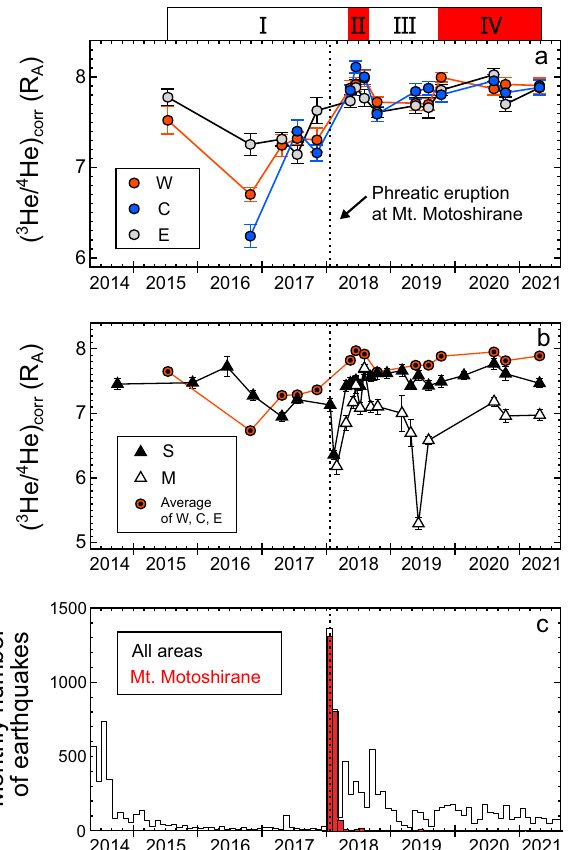
Figure 2. Temporal variations in air-corrected 3 He/ 4 He (( 3 He/ 4 He) corr ) ratios of fumarolic gases and monthly numbers of volcanic earthquakes at Kusatsu-Shirane volcano. ( a ) ( 3 He/ 4 He) corr ratios measured at the W, C, and E fumaroles in the Kitagawa geothermal area. The Roman numerals above the panel are periods defined by the average ( 3 He/ 4 He) corr ratios of the Kitagawa fumarolic gases. High average ( 3 He/ 4 He) corr ratios (> 7.8 R A ) were measured in periods II and IV. ( b ) ( 3 He/ 4 He) corr ratios measured at the Sesshogawara (S) and Manza (M) fumaroles, and the averages of W, C, and E fumaroles. ( c ) Numbers of volcanic earthquakes per month in all areas of Kusatsu-Shirane (white) and near Mt. Motoshirane (red). The earthquake data are provided by the Japan Meteorological Agency. Dotted lines indicate 23 January 2018, when a phreatic eruption occurred at Mt.